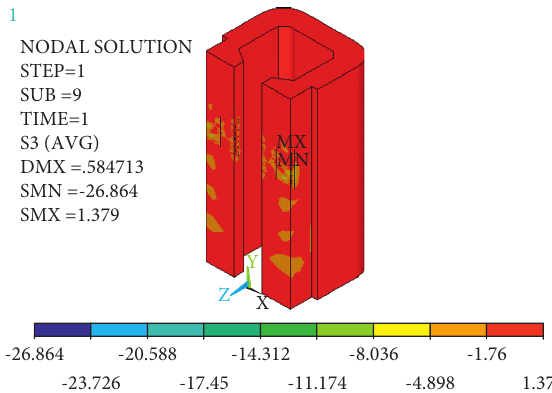
Figure 15: Principal compressive stress distribution of the concrete cable tower